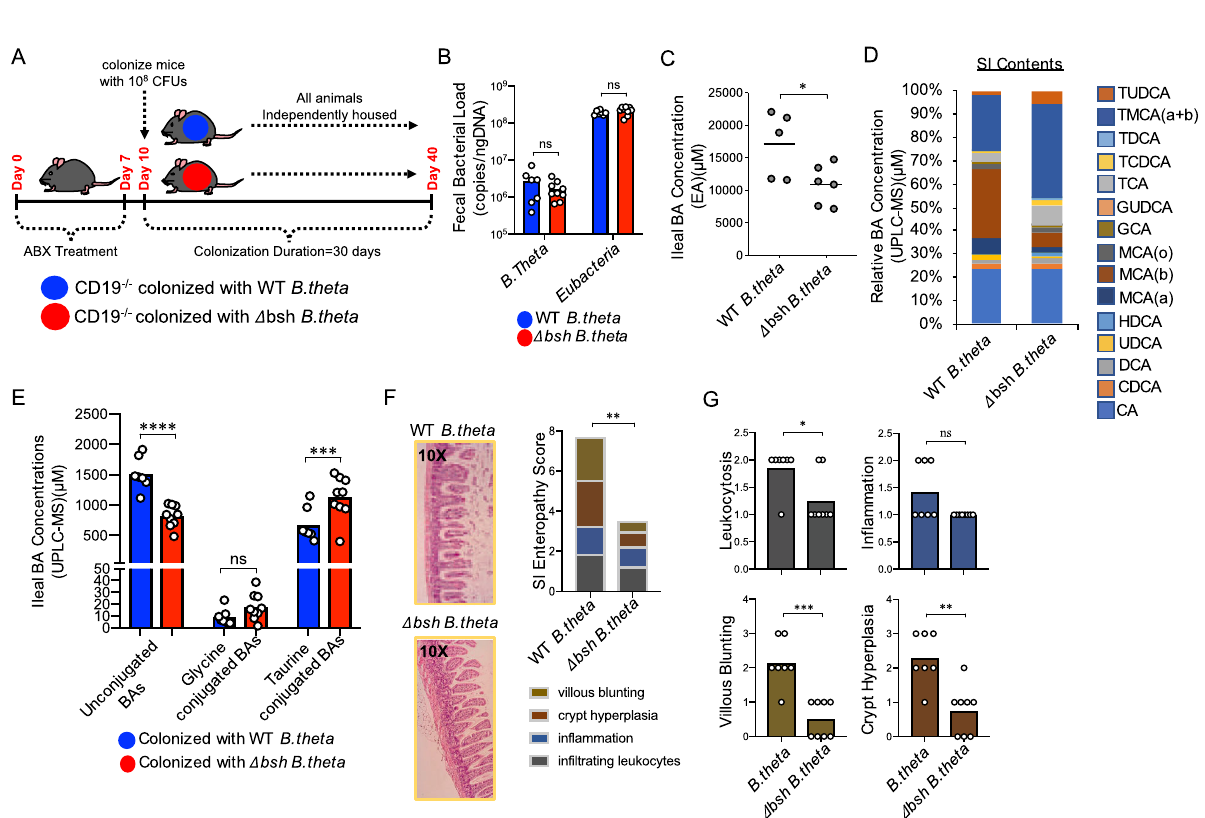
Fig. 7 Microbial bsh activity drives BA defects and contributes to SI enteropathy in CD19 − / − mice. A Schematic overview of B.theta and Δ bsh B.theta colonization experiments. B qPCR estimates of the relative abundance of B.theta , Δ bsh B.theta , and total Bacteroides are shown. Sidak ’ s multiple comparisons test; B.theta , ns = p = 0.9972, Eubacteria, ns = p = 0.1483. C Ileal BA concentrations in B.theta -colonized and Δ bsh B.theta -colonized CD19 − / − mice are shown. Two - tailed unpaired Student ’ s t-test; * = p = 0.03. D Stacked bar-chart illustrating general shifts in BA abundance as measured by UPLC-MS. Source data are provided as a Source Data fi le. E The relative abundance of unconjugated and conjugated BAs in B.theta and Δ bsh B.theta -colonized CD19 − / − mice are shown. Sidak ’ s multiple comparisons test; ns = p = 0.9998, *** = p = 0.0007, **** = p < 0.0001. F SI enteropathy scoring is shown for CD19 − / − mice colonized with WT B.theta ( n = 7) or Δ bsh B.theta ( n = 8). Two-tailed unpaired Mann – Whitney U test; ** = p = 0.002. G Comparison of individual features of SI enteropathy between CD19 − / − mice colonized with WT B.theta or Δ bsh B.theta . Two-tailed unpaired Mann – Whitney U test; ns =